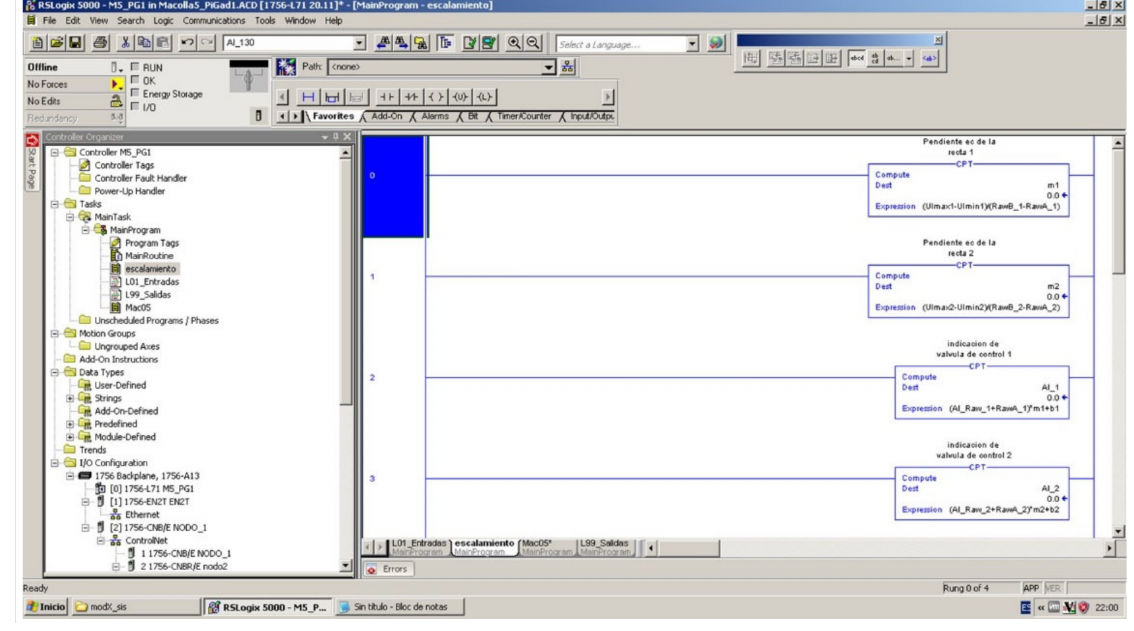
Figure 15. Signal scaling.